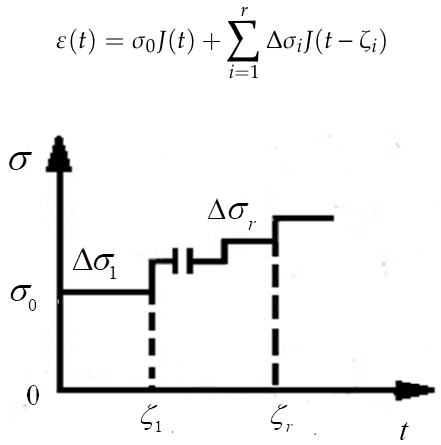
Figure 1. Burgers ’ model.